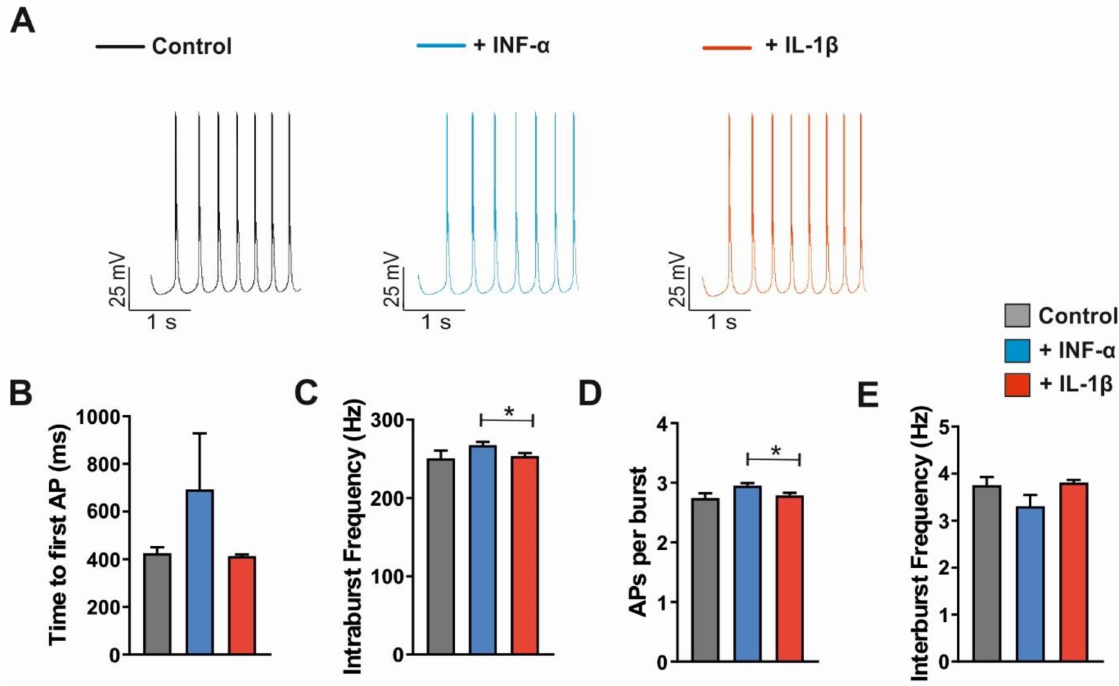
Figure 12. The NEURON-modeled influence of INF- α and IL-1 β application on the spontaneous burst activity of TC neurons. ( A ) Exemplary simulations of spontaneous burst activity under control condition, INF- α or IL-1 β application. ( B – E ). The bar graphs displaying characteristics of bursting: time to first action potential ( B ), intraburst frequency ( C ), action potentials per burst ( D ), and interburst frequency ( E ). * indicates p values less than 0.05.